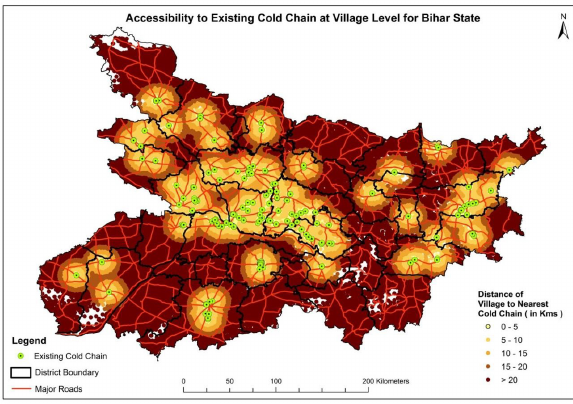
Figure 6. Distance from village to existing cold storages Based on these proportions of potato and horticulture, land cover at village level (Figures 7 and 8), spatial clusters were evaluated that are indicators of significantly contributing regions in horticulture at village level. Figures 9 and 10 represent the output maps obtained from spatial clustering analysis and top two significance classes were combined to get the significant horticulture region which is shown in Figure 10. Figure 4. Methodology flow chart The significant region as shown in Figure 11 and distance analysis in Figure 6 were used to identify priority villages requiring cold storages.